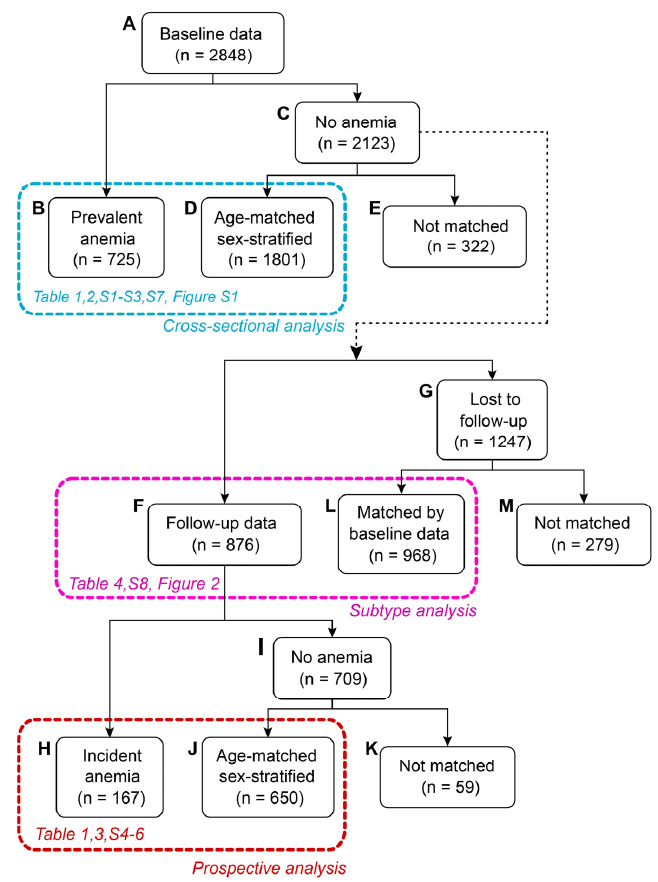
Figure 1. Selection of participants according to the study design. In total, nutritional data were available for 2848 participants ( A ). For the cross-sectional analyses, age-matched individuals with or without anemia were selected for sex-stratified comparison ( B , D ). Individuals without anemia at baseline ( C ), including those that could not be matched for the cross-sectional study ( E ), were eligible for the follow-up analyses. Follow-up data were available for 876 individuals ( F ) of whom 167 develop anemia ( H ) and 709 did not ( I ) during the follow-up period. For statistical comparisons, an age-matched and sex-stratified approach was applied ( H , J ), without the 59 individuals ( K ) who could not be matched with incident cases of anemia ( K ). Participants at risk who did not have follow-up data ( G ) were matched against the individuals with data ( F ) to create an independent baseline self-organizing map. The remaining individuals were not used for subtype analyses ( M